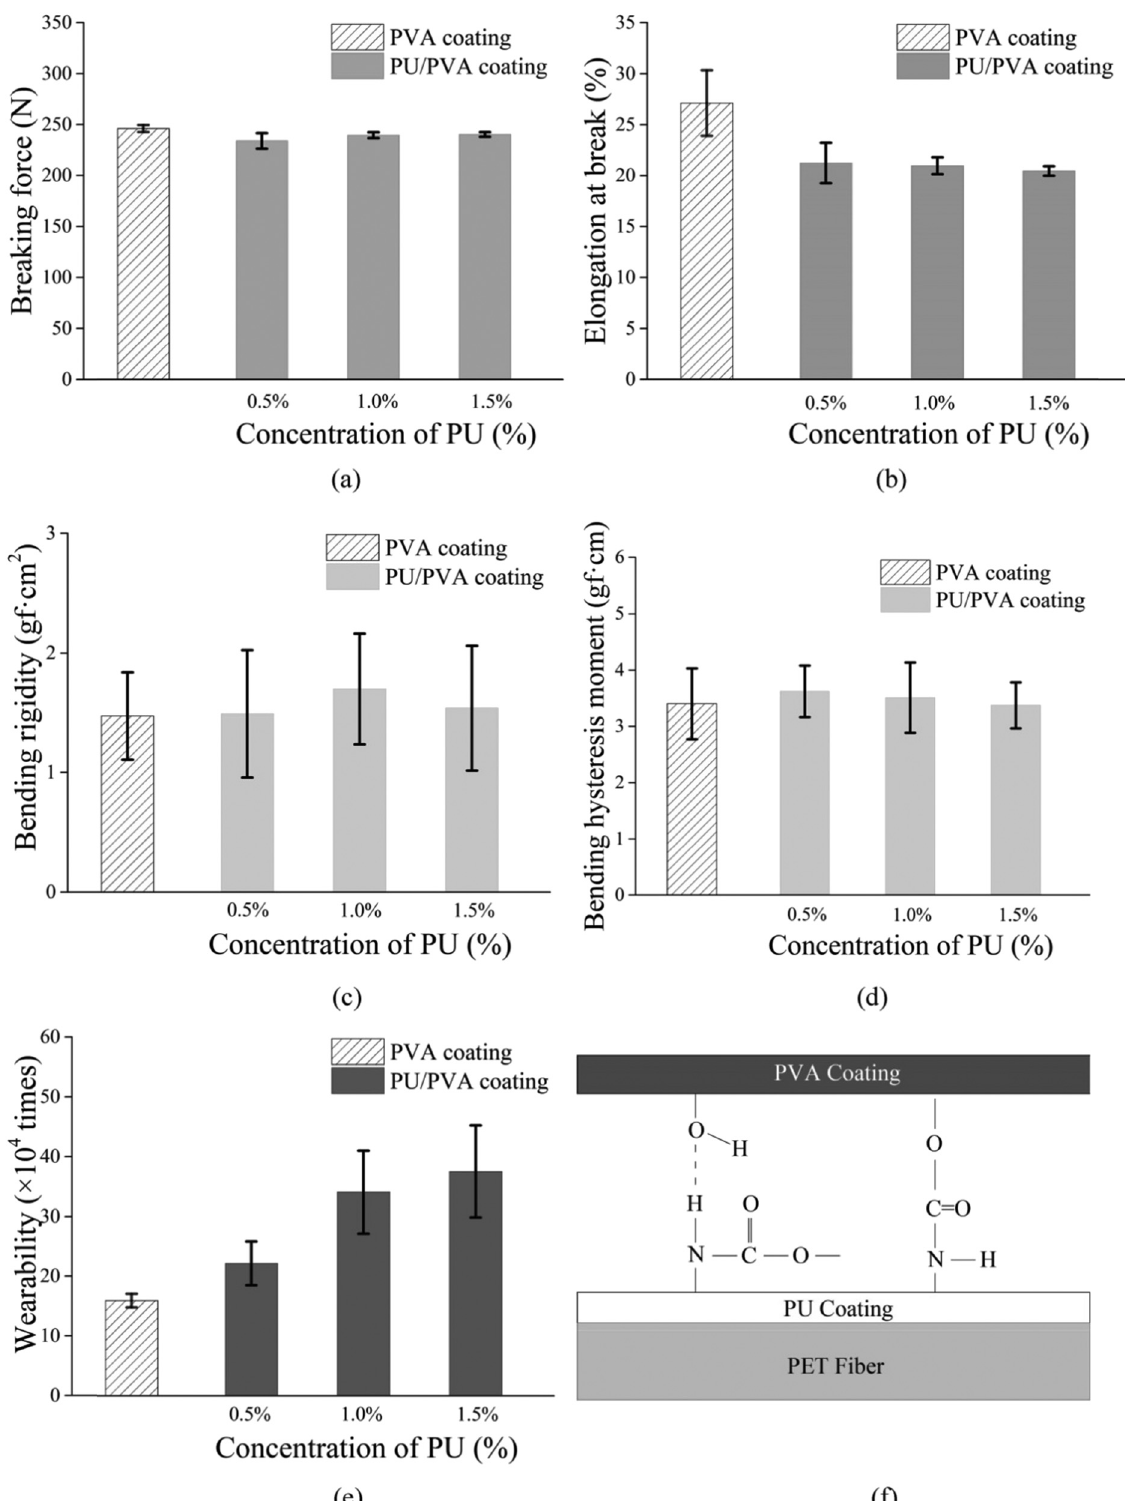
Figure 9: ( a ) Breaking force of coated harness cord with PVA and PU/PVA. ( b ) Elongation at break of coated harness cord with PVA and PU/PVA. ( c ) Bending rigidity of coated harness cord with PVA and PU/PVA. ( d ) Bending hysteresis moment of coated harness cord with PVA and PU/PVA. ( e ) Wearability of coated harness cord with PVA and PU/PVA. ( f ) Intermolecular interaction between PU and